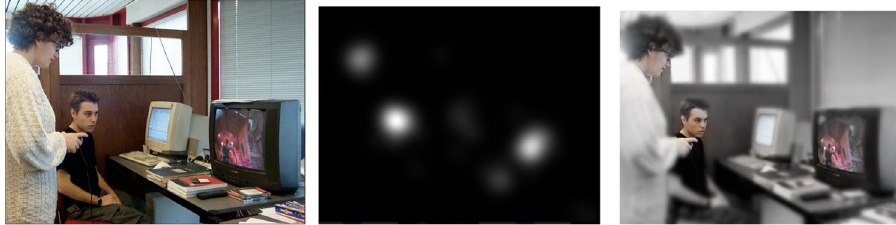
Fig. 1 Example of baseline and fi ltered image with heatmap of neurotypical viewing from OSIE open-source data set. Right image is a sample picture from the OSIE dataset in its raw form. The middle image is the heatmap of neurotypical viewing, the left image is the fi ltered version of the same image using the global fi ltered we created. This fi gure is not covered by the Creative Commons Attribution 4.0 International License. Reproduced with permission of LouAnne E. Boyd; copyright © LouAnne E Boyd, all rights